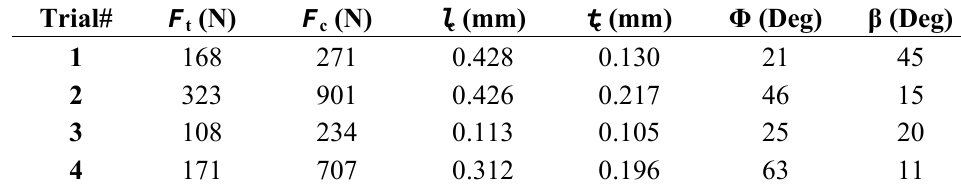
Table 2. Experimental results of the orthogonal machining.